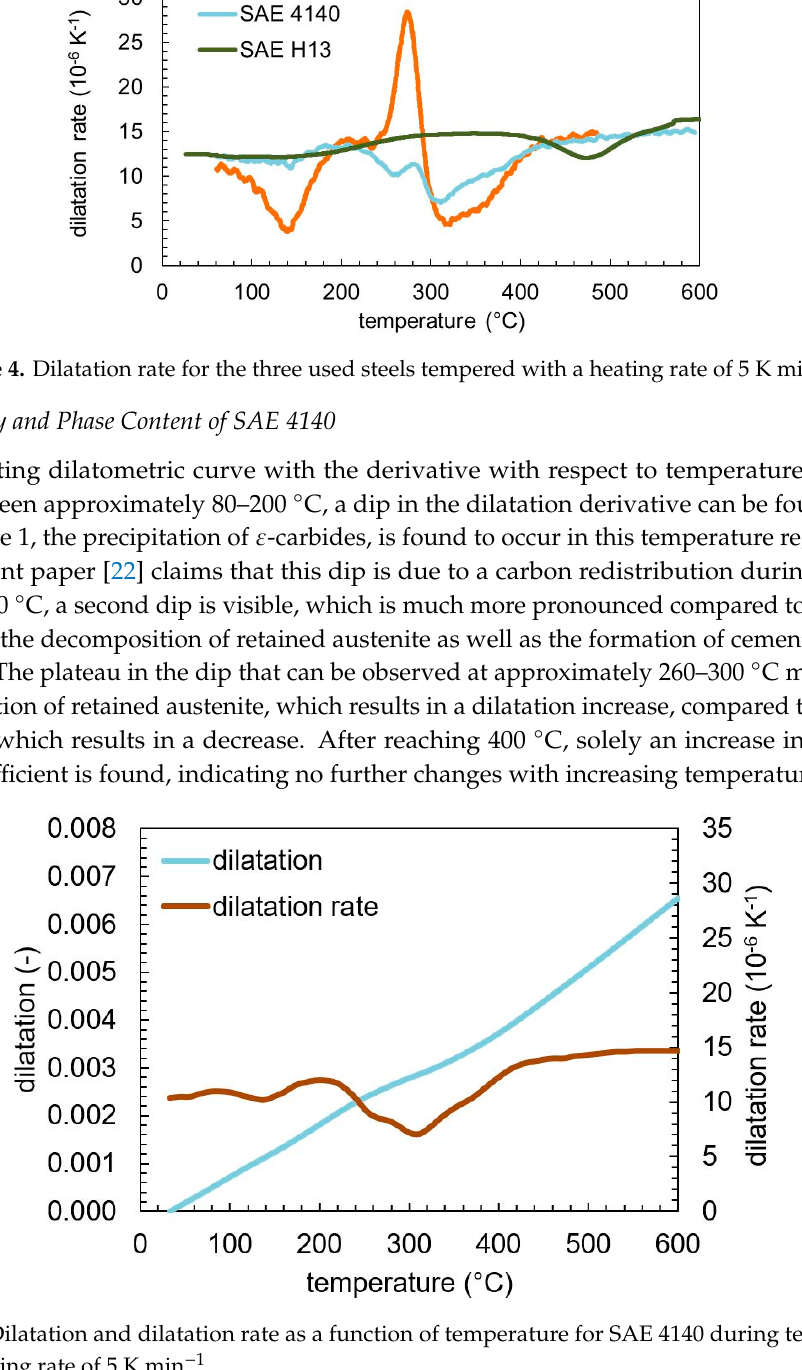
Figure 5. Dilatation and dilatation rate as a function of temperature for SAE 4140 during tempering with a heating rate of 5 K min − 1 .